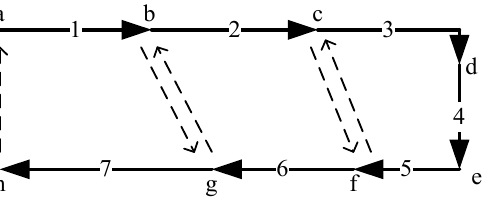
Figure 1. An example of walking paths in a U-shaped conveyor assembly line.